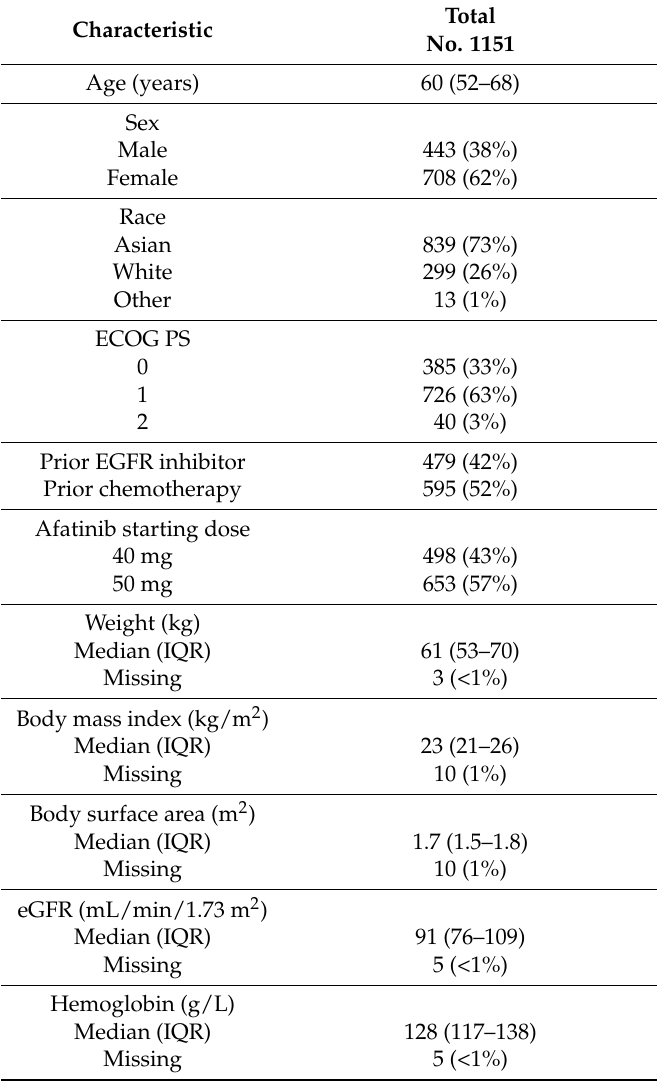
Table 1. Summary of pre-treatment characteristics for study participants commencing